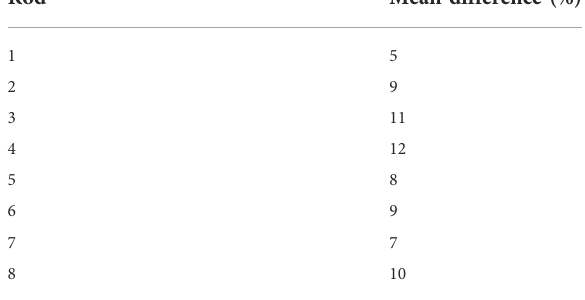
TABLE 3 Mean differences between experimental and numerical tracer gas test results. Rod Mean difference